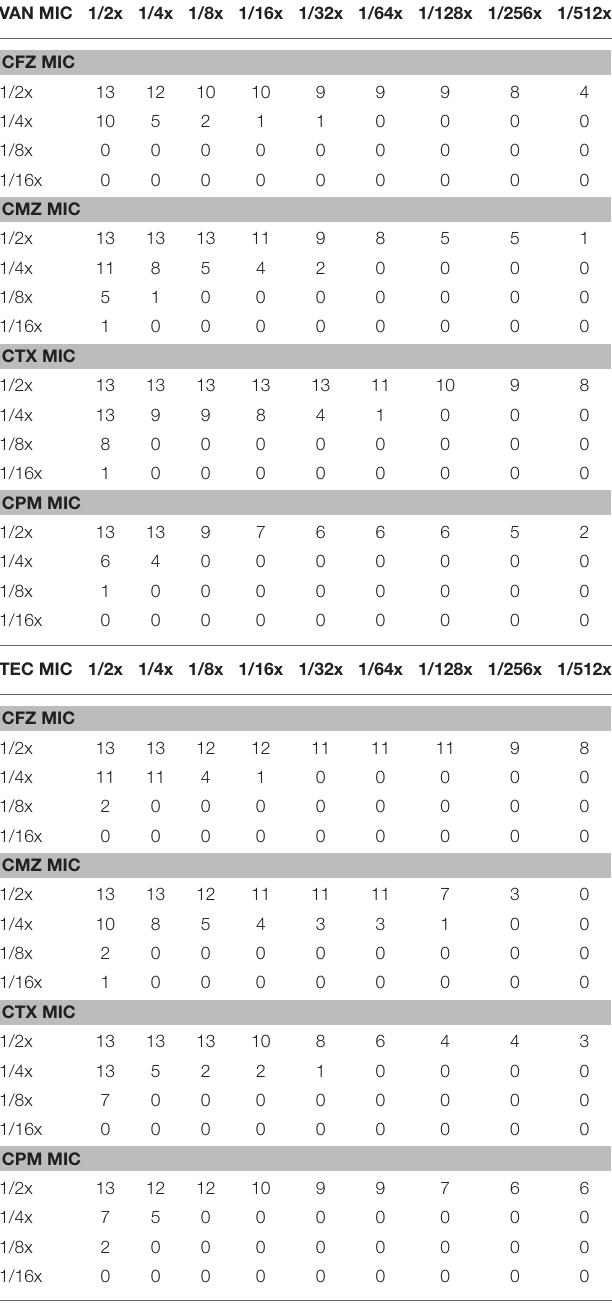
TABLE 3 | The inhibitory effect of vancomycin (VAN) or teicoplanin (TEC) in combination with one of four cephalosporins at a series of 2-fold dilution for 13 methicillin-resistant Staphylococcus aureus isolates with a high-cefazolin